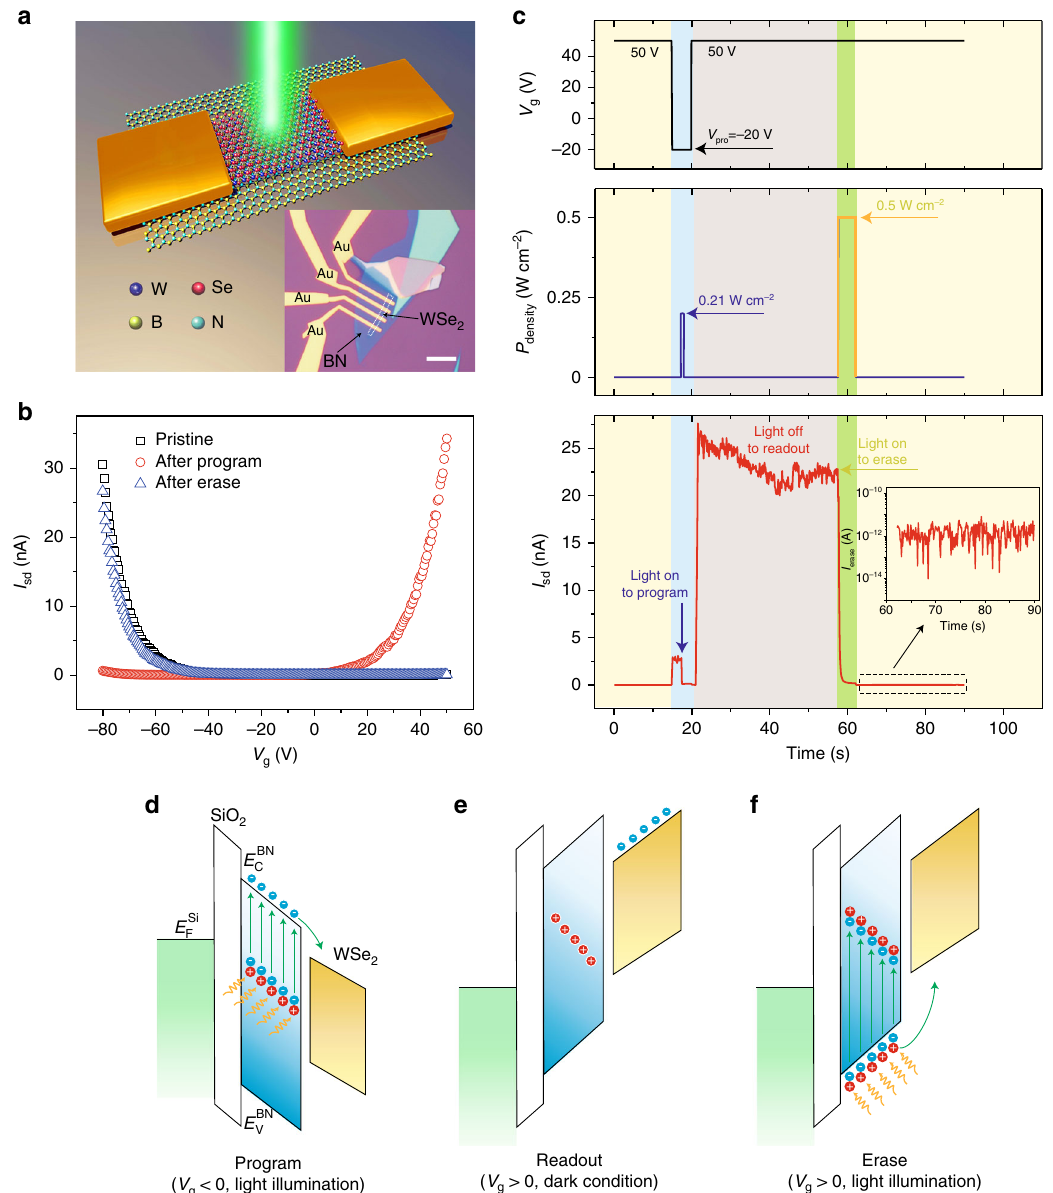
Fig. 1 Operational mechanism of the WSe 2 /BN heterostructure-based optoelectronic memory. a Schematic illustration of the optoelectronic memory fabricated by transferring WSe 2 fl ake on BN fl ake. The dark blue, red, yellow, and light blue balls represent the W, Se, B, and N atoms, respectively. Inset: optical image of the fabricated WSe 2 /BN heterostructure. The scale bar is 10 µ m. b The transfer curves of pristine, programmed, and erased WSe 2 /BN device at V sd = 1 V. The programming gate is − 20 V. The transport characteristic of the WSe 2 /BN FET was converted from hole-domination to electron- domination after programming, followed by a return to hole-domination after erasing. c A single program-readout-erase cycle of the WSe 2 /BN memory at V = − 20 V. The shaded backgrounds in light yellow, blue, gray, and green represent the device states as pristine, programming, readout, and erasing, pro respectively. Inset: plot of the erased current. Schematic of the band diagrams of the WSe 2 /BN optoelectronic memory under programming ( d ), readout ( e ), and erasing processes ( f ). The rectangle in grayish green represents the Si band diagram, while the parallelograms in white, blue and khaki represent the band diagrams of SiO 2 , BN, and WSe 2 , respectively. The red and blue circles represent the positive charges and electrons, respectively. E Si is the Fermi F level energy of Si substrate. E BN and E BN represent the minimum energy of conduction band and the maximum energy of valance band of BN, C V rises with increasing V pro , which indicates a signi fi cant gate- Fig. 2c, the switching ratio is largely enhanced from 3.8 × 10 3 to tunable electron-doping effect on WSe 2 . The dynamic behavior of 1.1 × 10 6 when V pro increases from 0 to − 80 V. The larger the WSe 2 /BN optoelectronic memory modulated by V pro is also negative backgate can better stabilize the generated positive charges in middle of the BN bandgap and facilitate the formation investigated (Fig. 2b). When the V pro is switched from 0 V to − 80 V with − 10 V step, the storage current increases stepwise, gen- of higher concentration of positive charges in BN, which can erating 9 clear storage states. The switching ratio at different V pro result in more effective electron-doping and greater storage cur- rent in WSe 2 . is obtained through extracting the storage current. As shown in